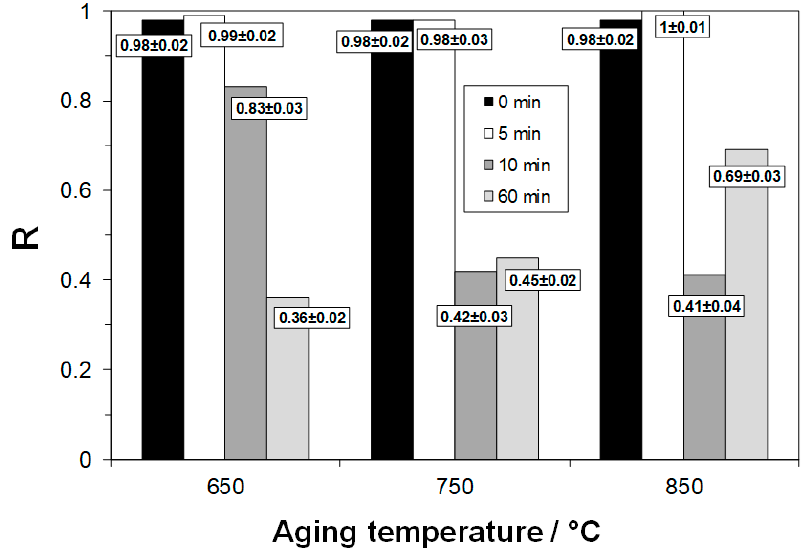
Figure 14. SCC susceptibility (R index) of DSS 2304, before and after thermal aging, obtained by SSRT in NACE solution containing 10 − 3 M S 2 O 32 − . in NACE solution containing 10 − 3 M S